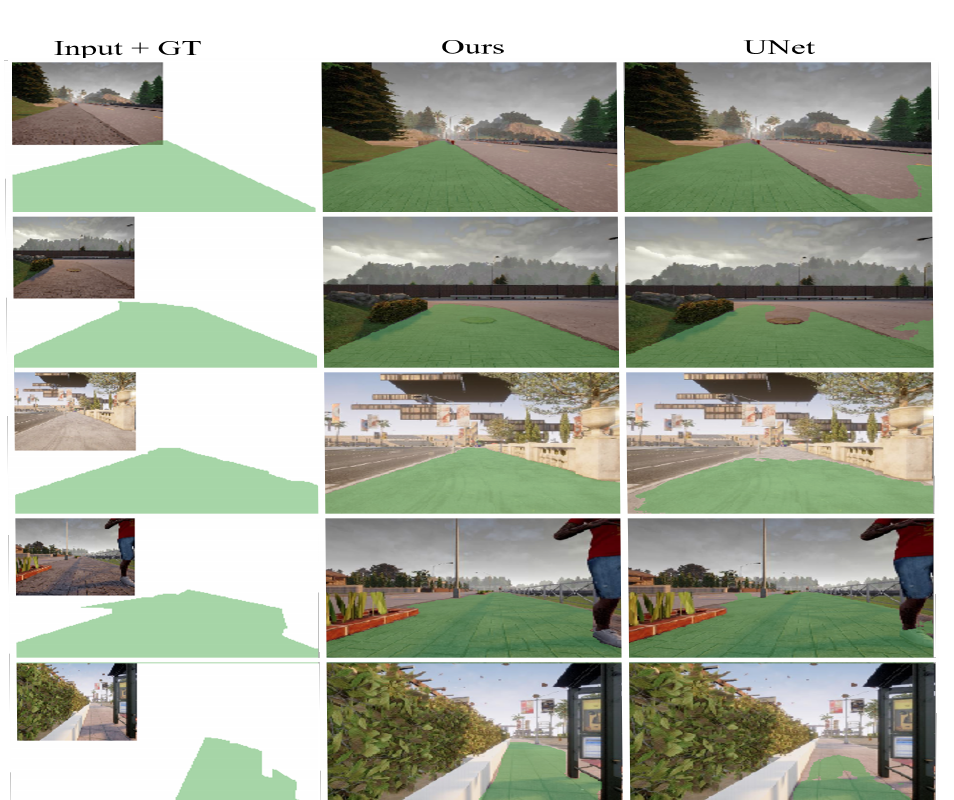
Figure 8. Semantic segmentation results of the proposed method and the U-Net model. The first column presents the image input and the corresponding ground truth (GT) semantic label. The second column presents the results obtained from our model. The third column presents the results obtained from the UNet